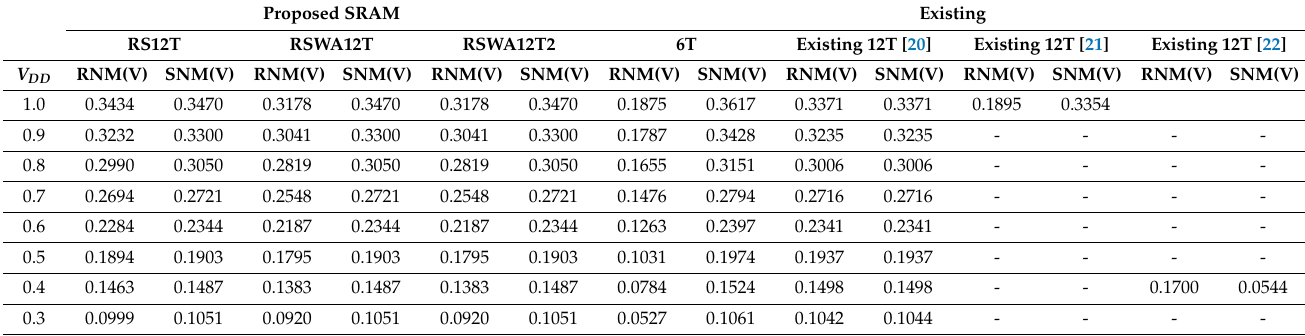
Figure 19. SNM butterfly curve for the proposed SRAM cell. Table 3. Comparative stability results and